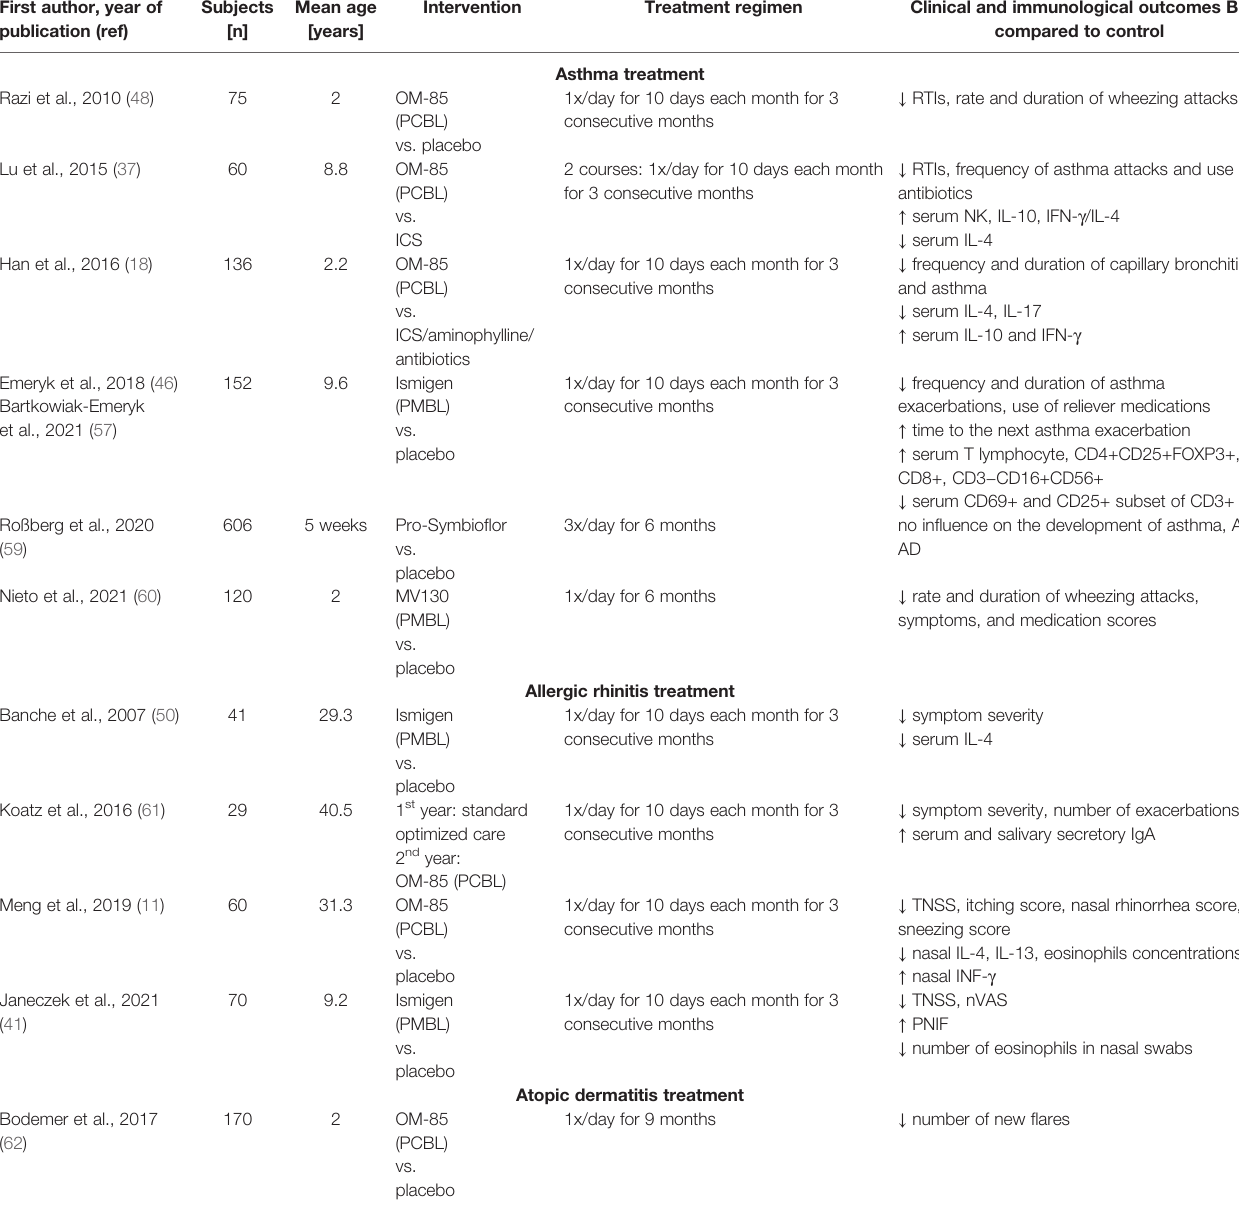
TABLE 1 | Characteristics of included